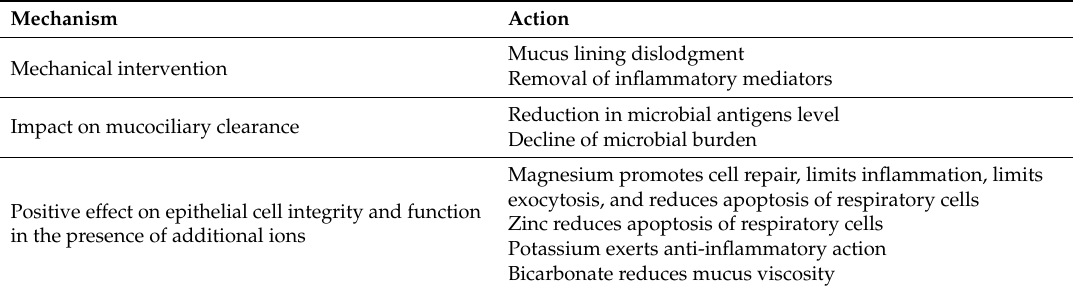
Table 1. Mechanisms of action of nasal irrigation